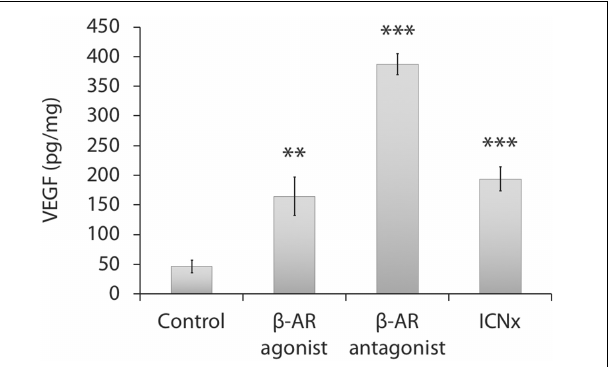
FIGURE 3 | Choroidal VEGF protein levels 14 days after laser injury in each experimental group ( n = 5 animals per group). Twelve laser burns were made in a single eye. VEGF levels in the treatment groups were significantly higher than levels in the control group. Units represent VEGF protein normalized to total protein. Error bars represent SD. ∗∗∗ P < 0.001; ∗∗ P <